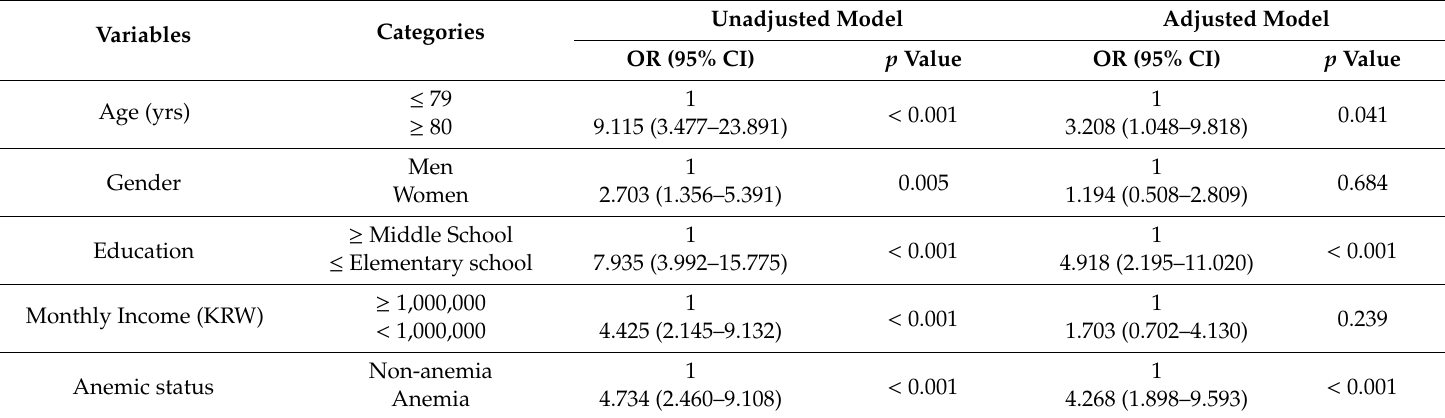
Table 3. Multiple logistic regression analysis of cognitive impairment among older adults with heart failure ( n =